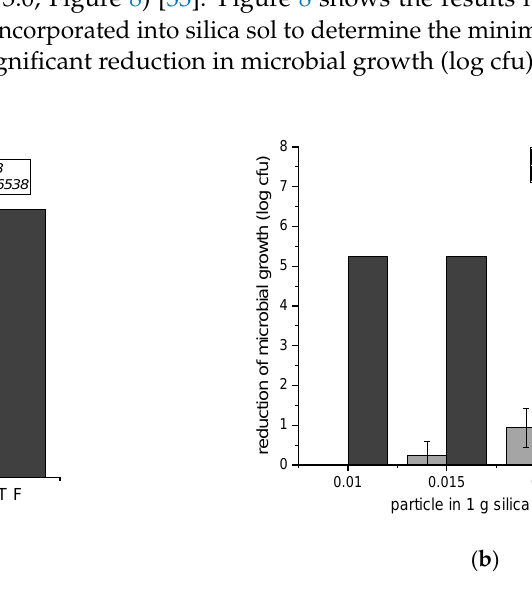
Figure 8. ( a ) Germ reduction in [log cfu] for E. coli DSM 5923 and S. aureus ATTC 6538 on ster- ilized substrate surfaces (PP: polypropylene, ProMa: prolamine–silica sol coating, MT: silica sol (trimethylethoxysilane); F: fumaric acid particles; GP: glassine paper 50 g/m 2 ); ( b ) germ reduction in [log cfu] for E. coli DSM 5923 and S. aureus ATTC 6538 on the sterilized substrate